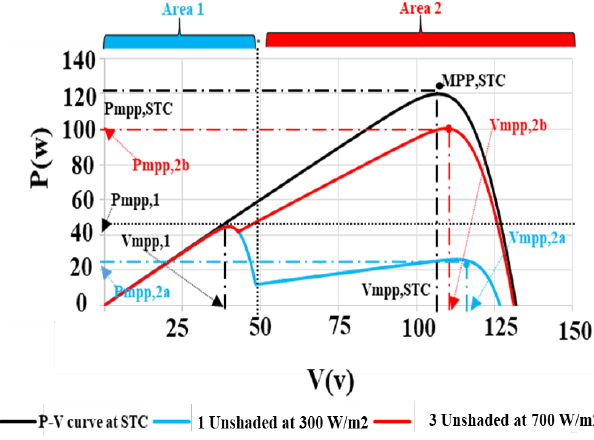
Figure 5. P-V curves of PV array for STC and for two shading scenarios. To apprehend the current flow direction of the PV array under PSC, consider the PV array shown in Figure 6 consisting of six PV panels, three of which were unshaded, while the others were shaded. In addition, as shown in Figure 5, the P-V curve of the PV array under PSC could be divided into two areas. In area 1, the bypass diode of each shaded PV panel conducted as a short circuit. Figure 6a depicts the equivalence diagram of the current flow direction of the PV array when the load demanded more than the current value of the shaded PV panels. Therefore, the equation of Vmpp1 can be expressed mathematically as follows: where V mpp 1 is the voltage at the first peak, N s is the number of PV panels, N sh is the number of shaded panels, and V mpp,STC is the voltage at the MPP of the PV array under STC. By contrast, in area 2, the bypass diodes of all PV panels were not conducting. Figure 6b depicts the equivalence diagram of the current flow direction of the PV array when the load demanded less than the current value of the shaded PV panels. Therefore, the equa- tion of Vmpp 2 can be expressed mathematically as follows: